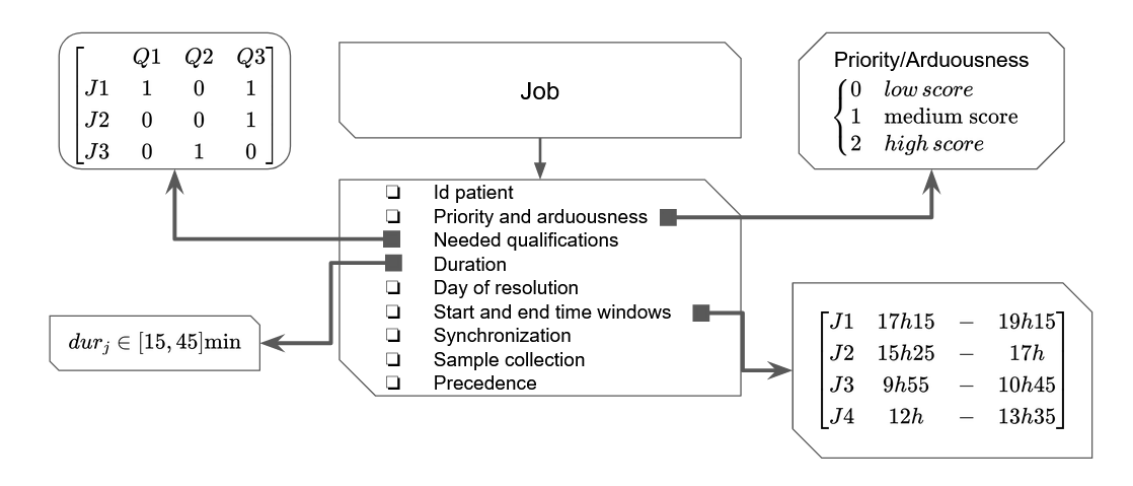
Figure 3. Description and summary of a